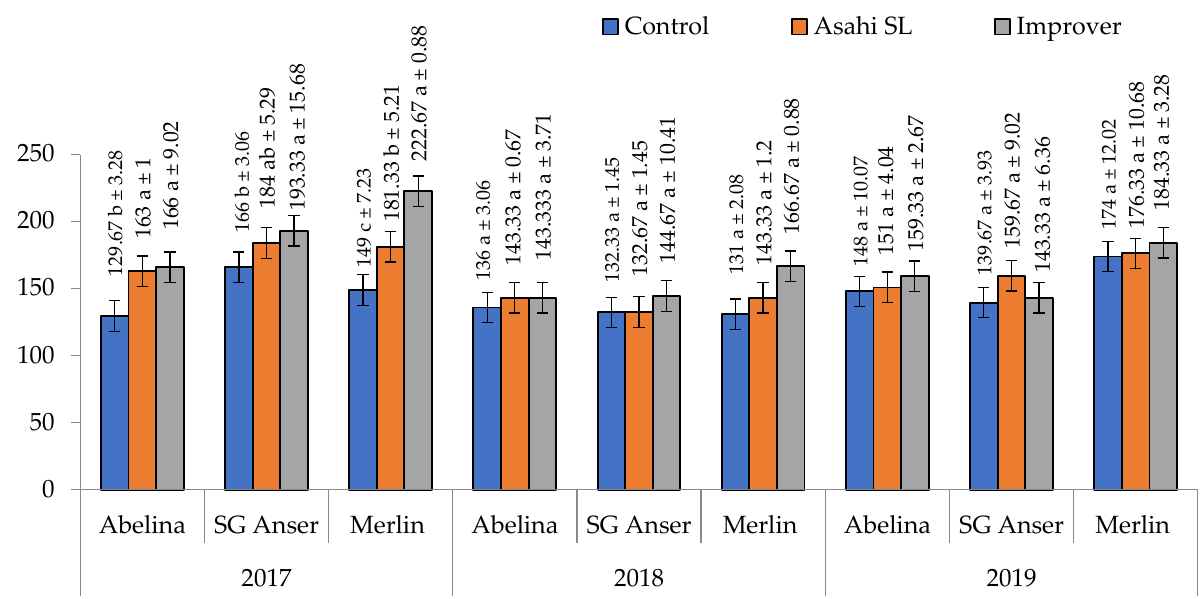
Figure 2. 1000-seed yield according to cultivars and biostimulants in 2017–2019. Means followed by different letters in lowercase: a, b, and c differ significantly at p ≤ 0.05; ± Se (standard error) value .